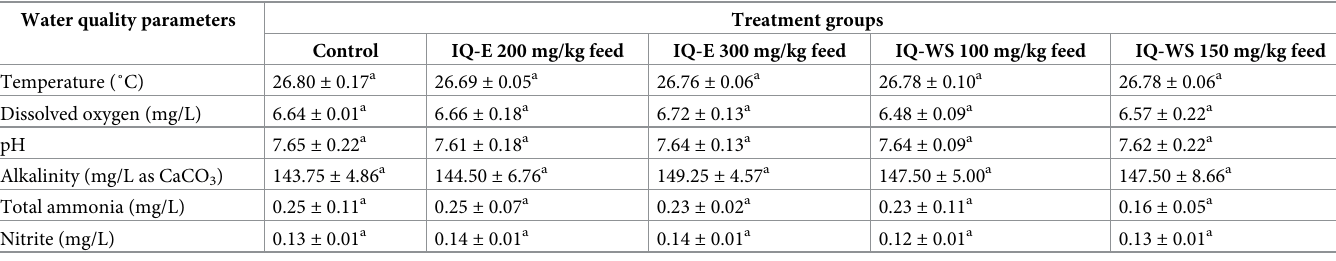
Table 2. Water quality parameters throughout the 30 day-feeding